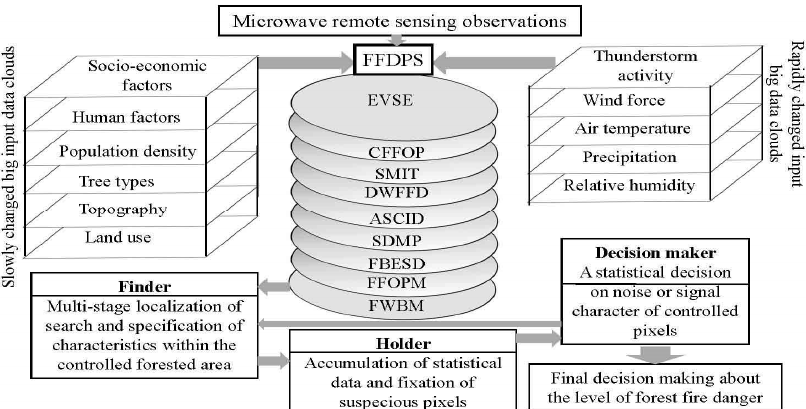
Figure 2. The main operational structure of the decision making system (DMS) as a monitoring system to detect areas prone to forest fires. The items of the forest fire danger prediction system (FFDPS) are described in Table 2. Table 2. The operational characteristics of the FFDPS items shown in Figure 2.